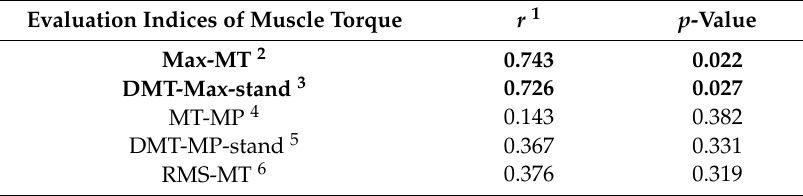
Table 4. Correlation analysis results for muscle torque and low back pain ( n =